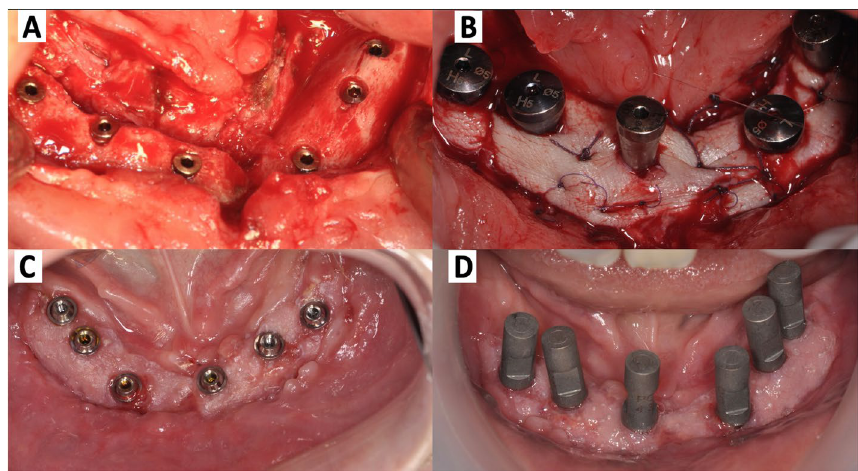
Fig. 7 Intraoral views during the dental implant rehabilitation a implant placement, b healing screws placement and gingival reconstruction by skin grafting, c the results after the placement of transmucosal abutments, and d intraoral digital prosthetic impression of the scan bodies